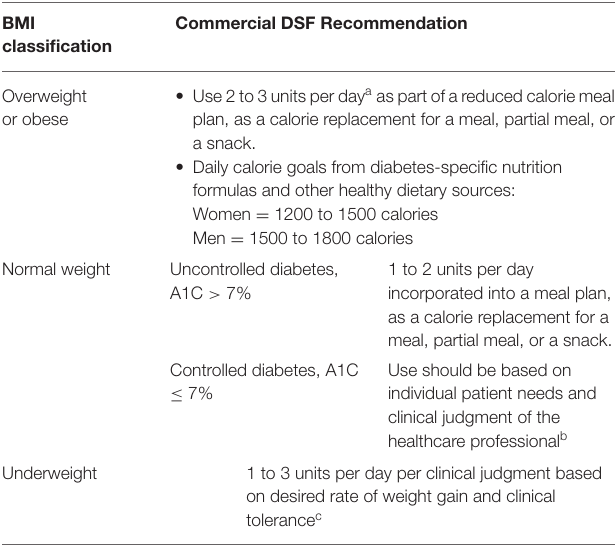
TABLE 6 | DSFs for prediabetes and diabetes *